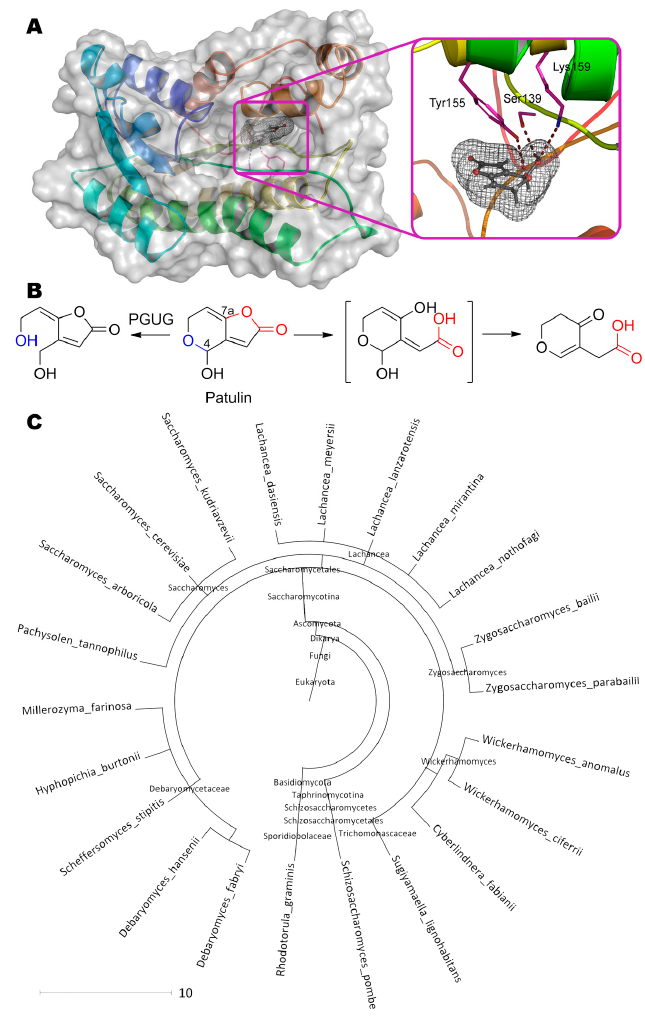
Figure 7. ( A ) Structure of enzyme PGUG containing patulin in its active center, and ( B ) scheme of substrate conversion with PGUG. Amino acid sequence was obtained from GenBank EDK41095.2 and folded using I-TASSER server. Position and geometry of substrate binding was determined as described early. ( C ) Phylogenetic tree of microorganisms possessing homologous enzymes found with BLAST.